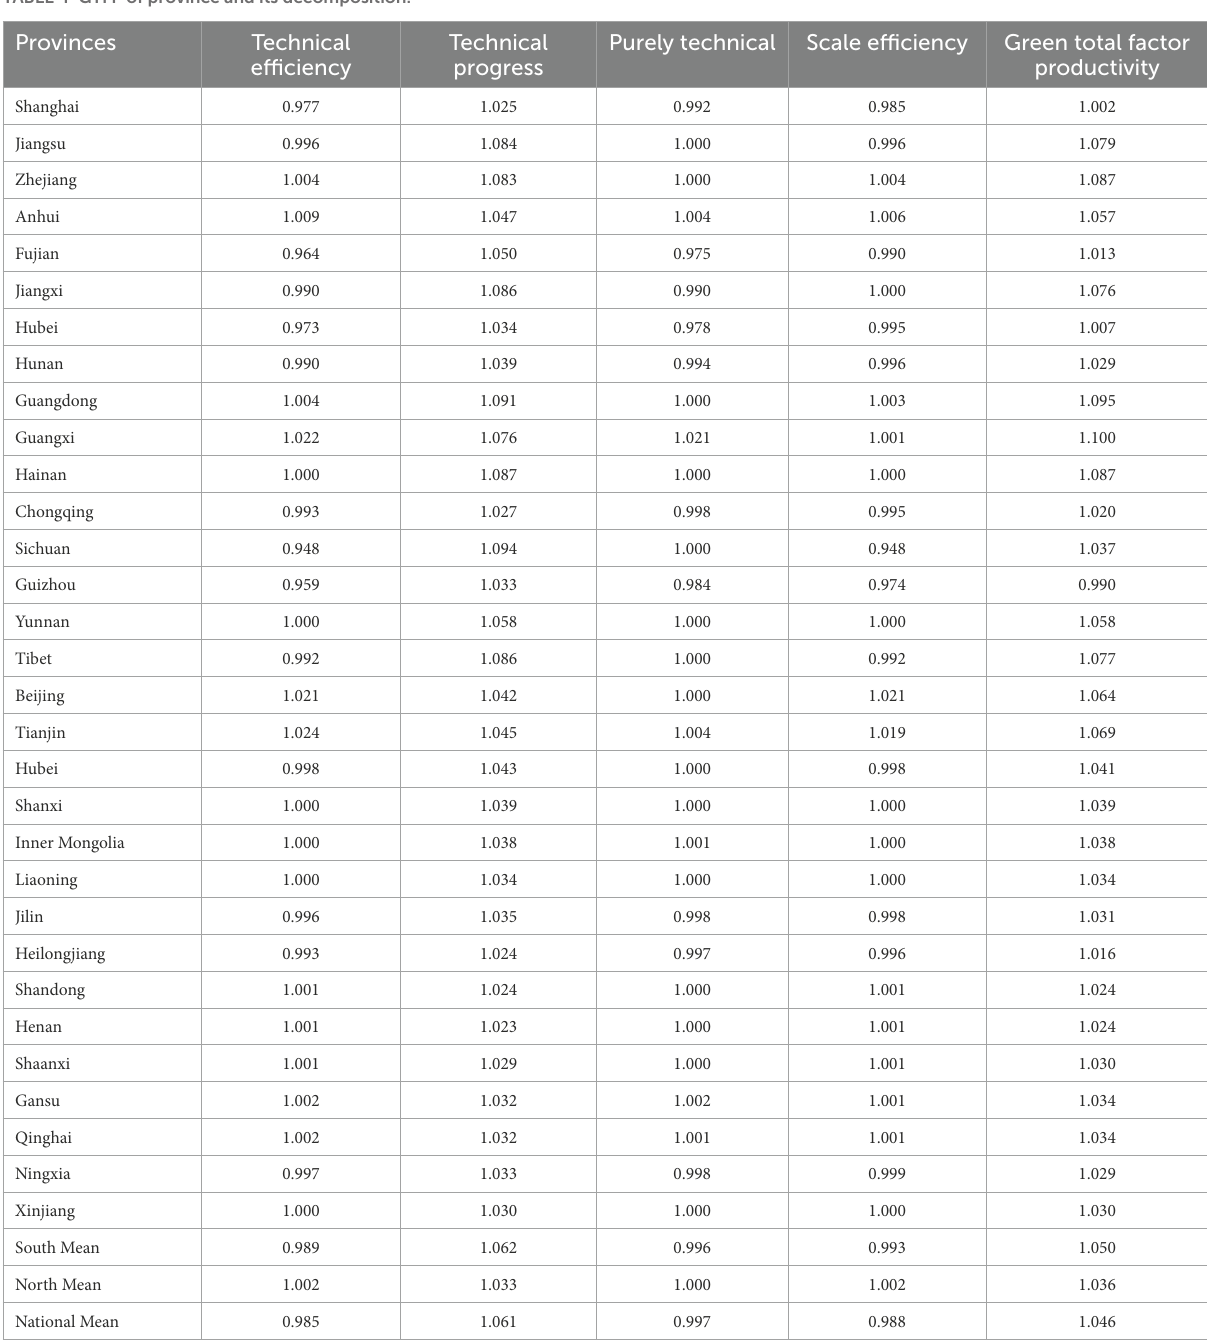
TABLE 4 GTFP of province and its